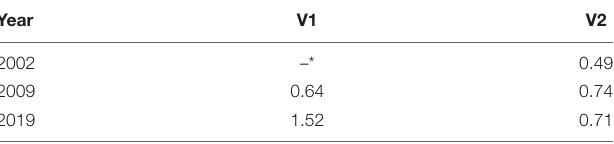
TABLE 1 | Area in hectares of gullies V1 and V2 over the